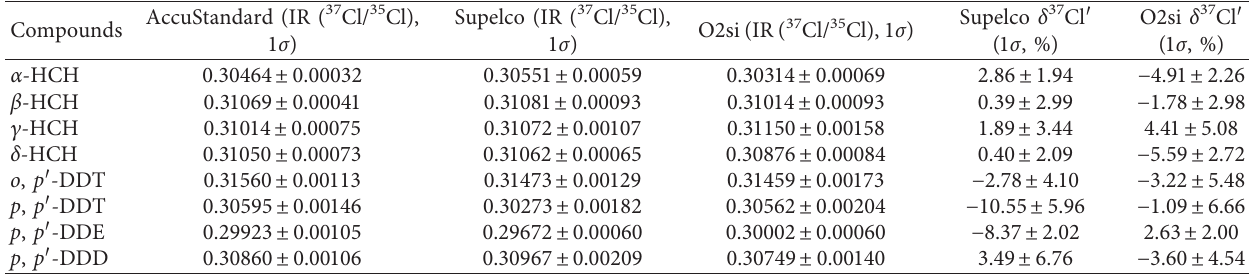
Table 2: Isotope ratios (IR ( 37 Cl/ 35 Cl)), standard deviations (1 σ ), and δ 37 Cl ′ for Supelco standards and O2si standards calculated in relation to external isotope standards from AccuStandard. AccuStandard (IR ( 37 Cl/ 35 Cl), Compounds